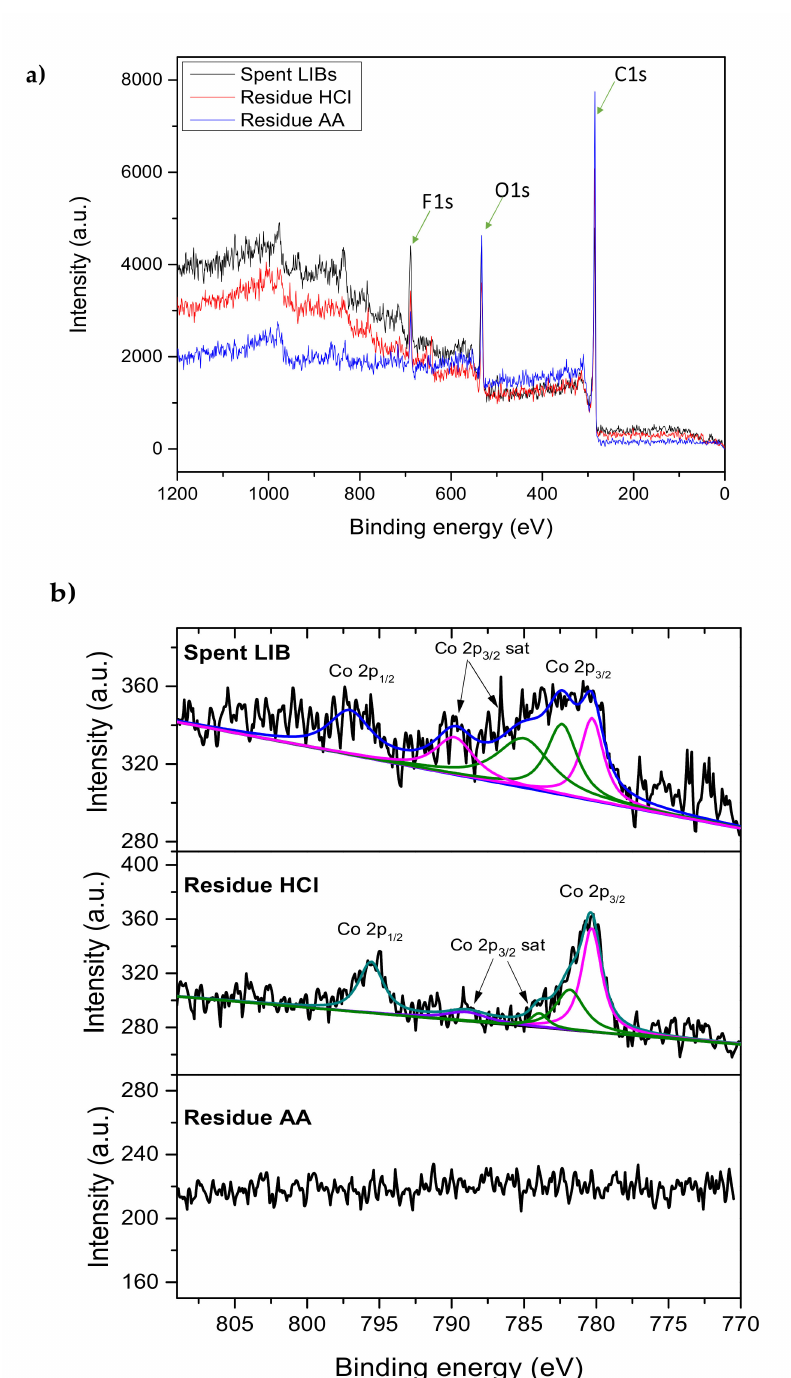
Figure 3. XPS result of spent LIBs and leaching residue using HCl and ascorbic acid (AA) in SWE ( a ) wide scan and ( b ) Co 2p